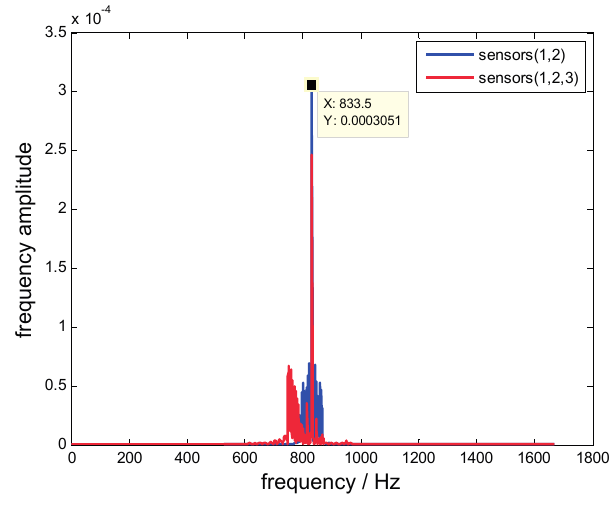
Figure 18. Frequency spectra of reconstructed